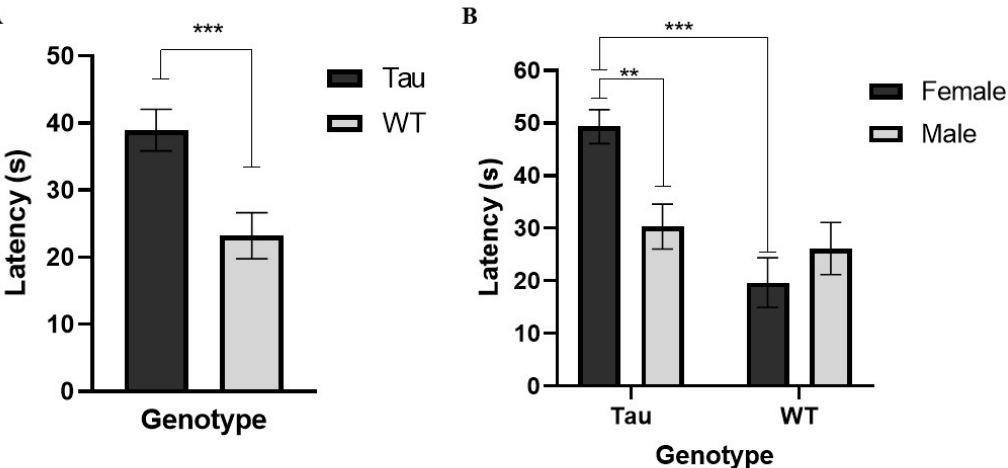
Figure 11. MWM probe trial latency to first cross platform. ( A ) Tau mice had a significantly longer latency to first reach where the platform would be than WT mice. ( B ) Female WT mice took signifi- cantly less time than female tau mice to first cross where the platform would be and female tau mice had a significantly longer latency to first cross where the platform would be than male tau mice. Error bars represent mean ± SEM (** p < 0.01, *** p ≤ 0.001).